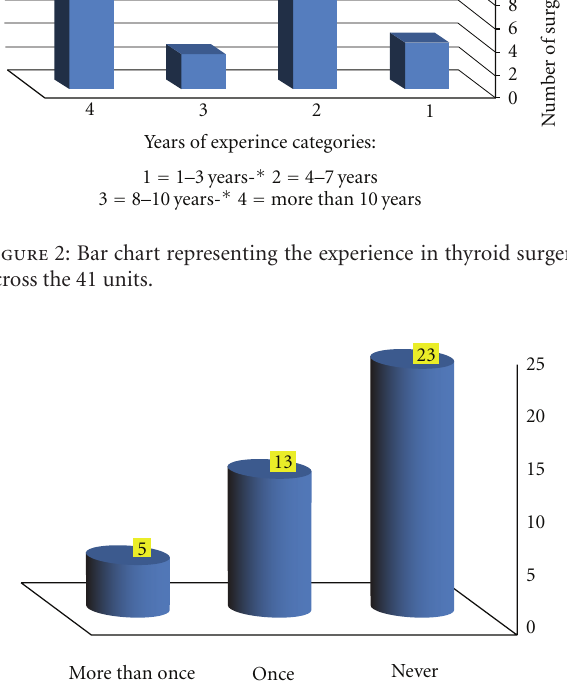
Figure 3: Bar chart representing the frequency of airway problems encountered.